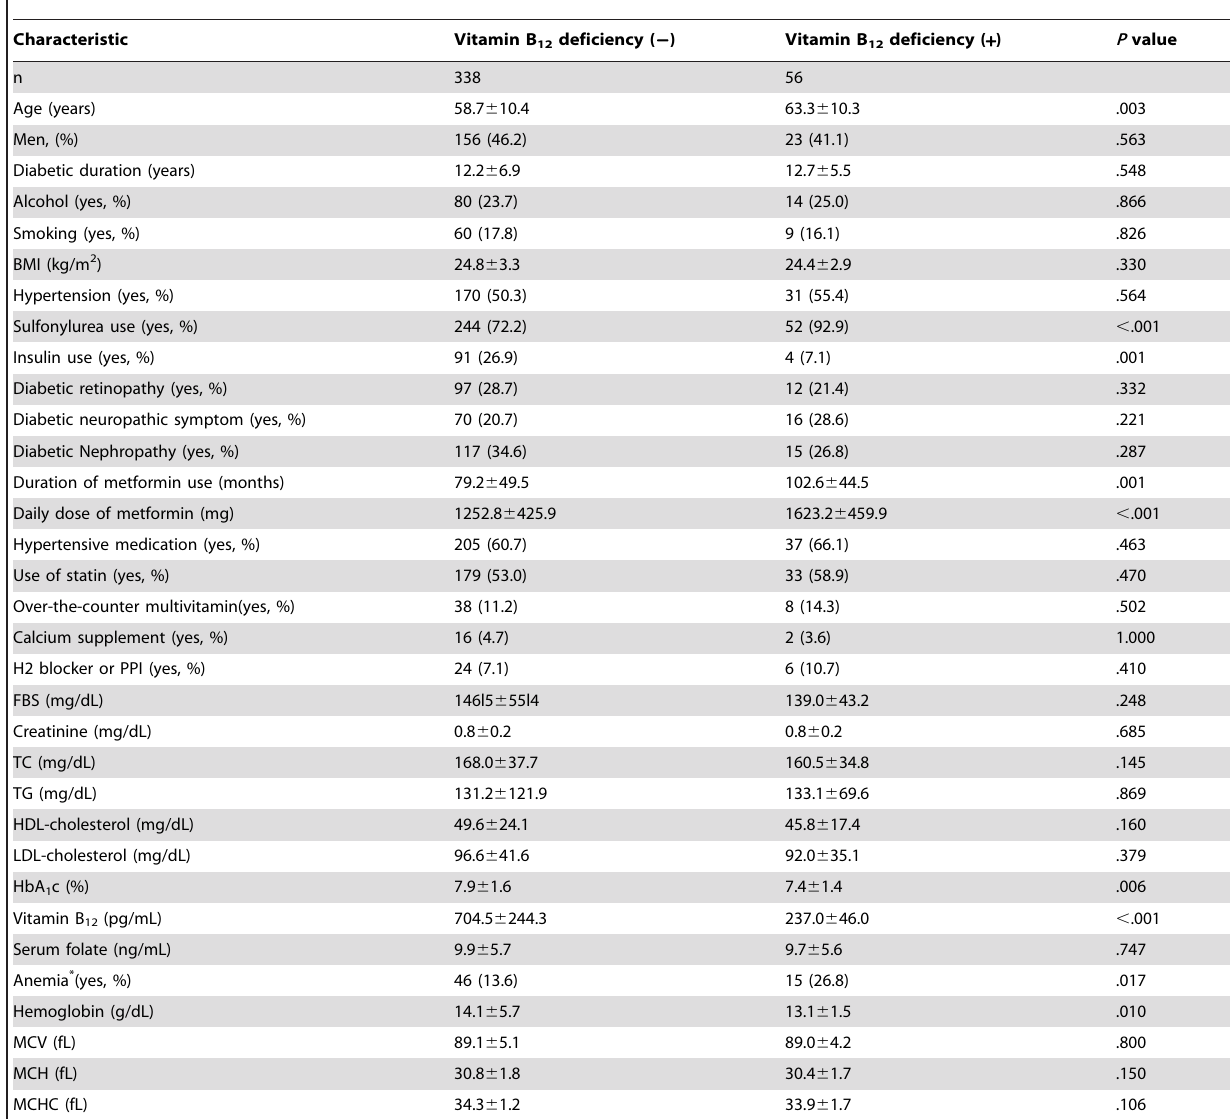
Table 3. Characteristics of the two selected groups according to vitamin B 12 deficiency.